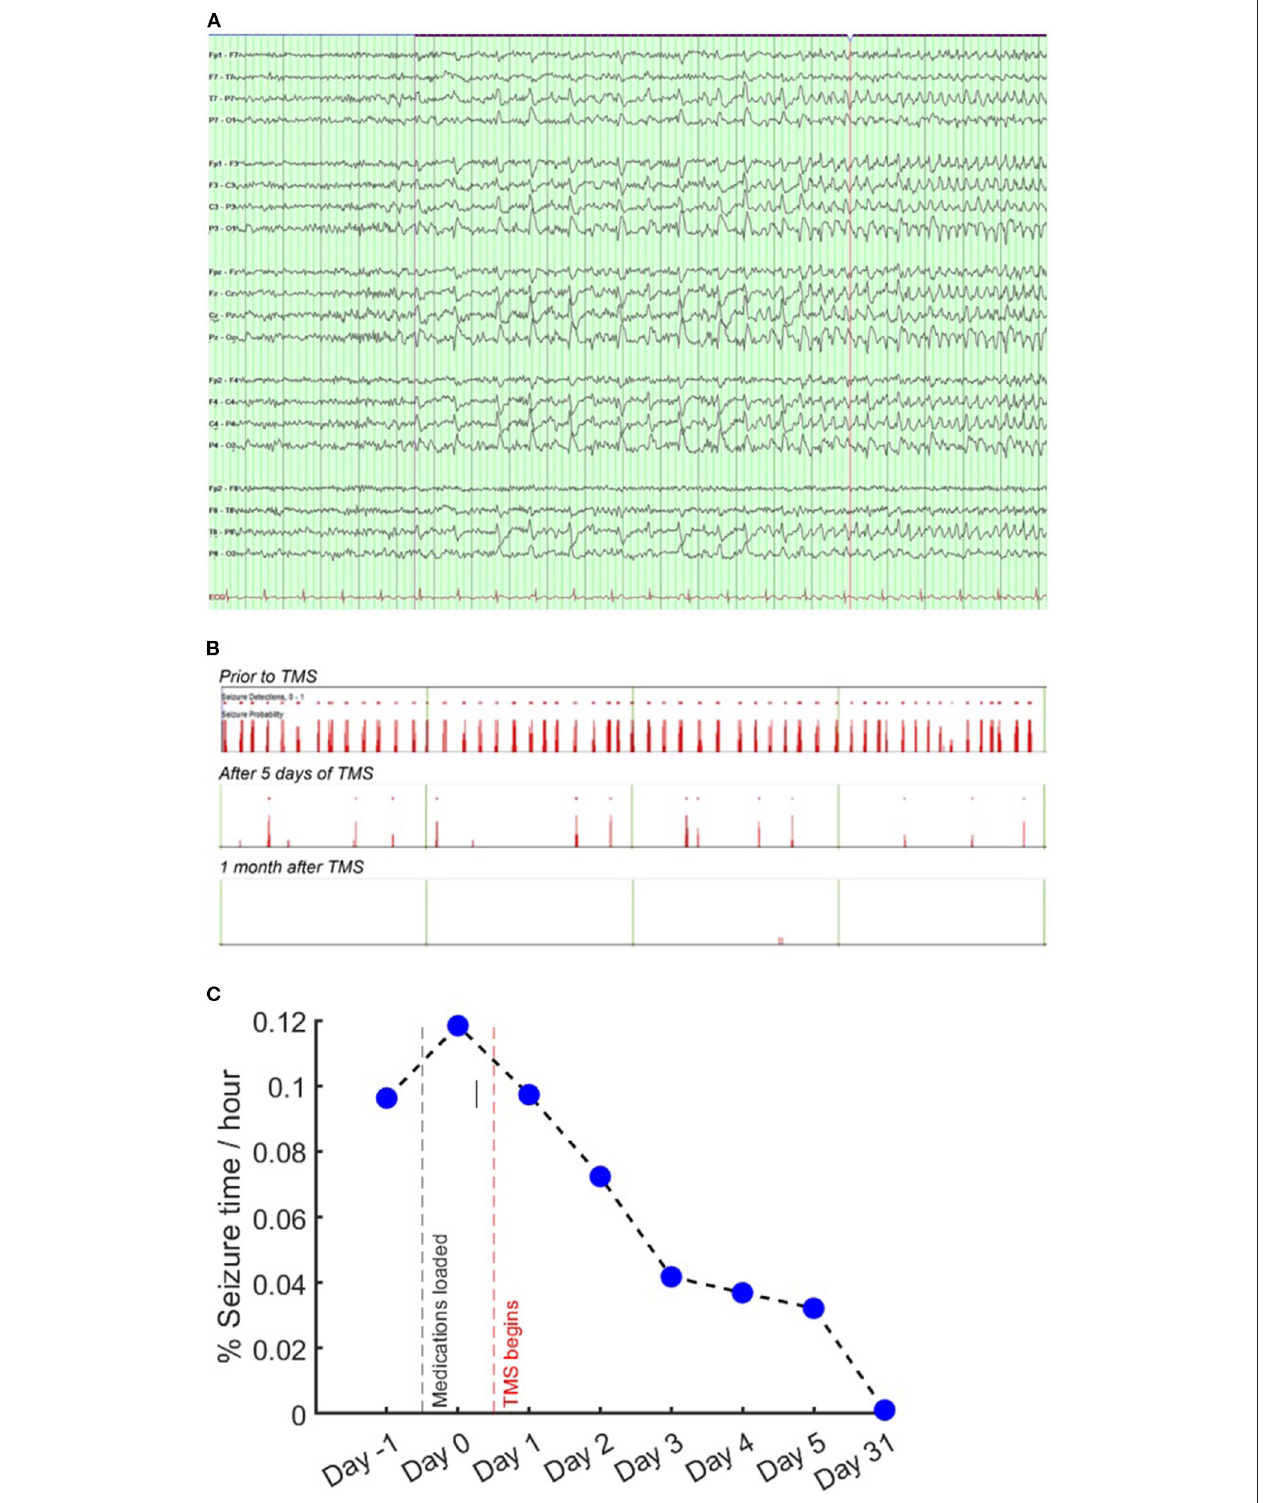
FIGURE 5 | EEG and seizure frequency. EEG seizure onset and automated seizure detections. (A) EEG seizure onset on longitudinal bipolar montage. EEG settings: low frequency filter 7Hz, high frequency filter 70Hz, sensitivity 7 uV/mm. (B) 16-h segments showing automated seizure detections (red bars) prior to stimulation; after 5 days of stimulation; and 1 month after TMS. (C) Percentage of time spent in seizure, showing an initial 22% increase after medication load, followed by day-by-day reduction after TMS treatment began.